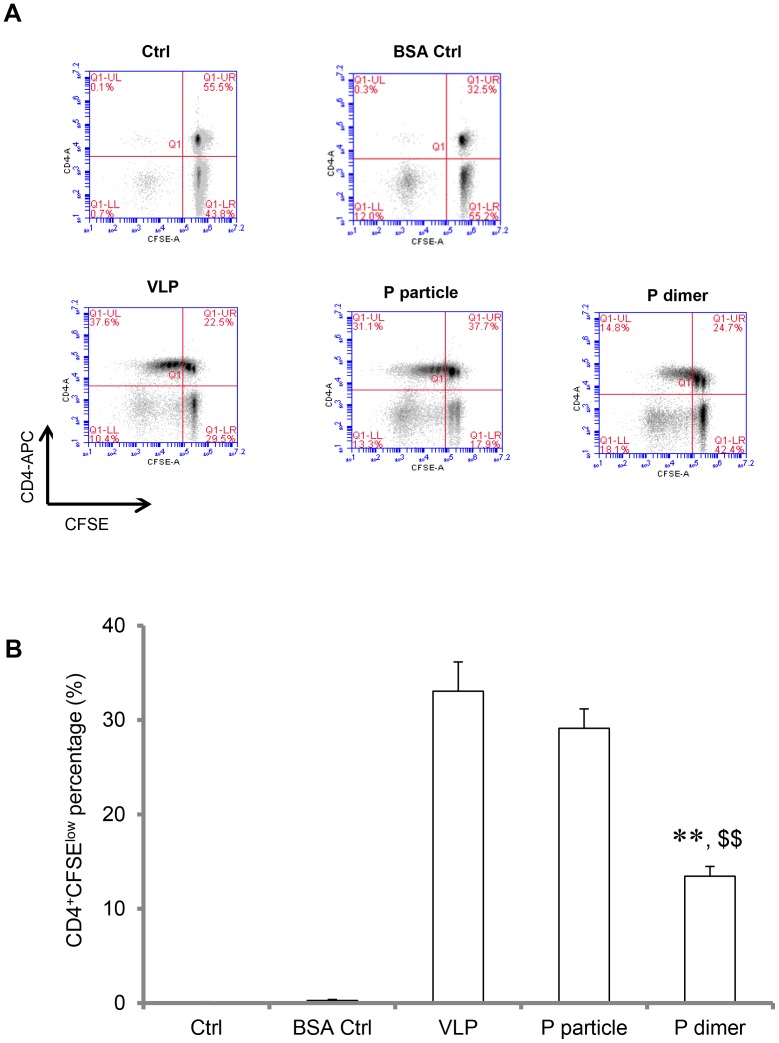
VA387-specific CD4+ T cells proliferation induced by antigen-pulsed dendritic cells (DCs).Splenocytes were isolated from immunized mice and labeled with carboxyfluorescein succinimidyl ester (CFSE). At the same time, mature bone marrow-derived DCs (BMDCs) pulsed with related antigens of VA387 VLPs, P particles, or P dimers were collected. Then, CFSE-labeled splenocytes were co-incubated with antigen-induced mature BMDCs for 5 days. Finally, cells were stained with APC-conjugated CD4 and were acquired by BD FACSCanto or BD Accuri™ C6. The resulting flow data were analyzed by FlowJo or Accuri™ C6 software. (A) Representative flow data of CD4+ T cell proliferation. (B) Percentages of proliferating CD4+ T cells (CD4+CFSElow population) were shown in bar graph. ∗ P<0.001 and ∗∗ P<0.0001 were calculated vs. VLP, while $ P<0.001 and $$ P<0.0001 were calculated vs. P particle. Experiments were repeated three times.